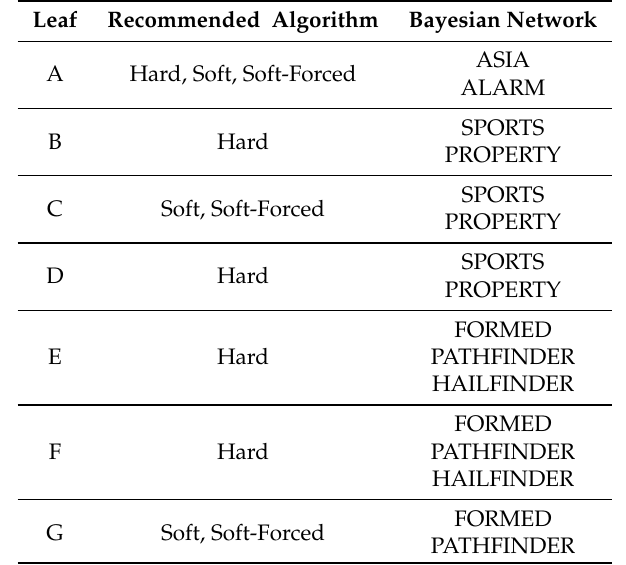
Figure 1. Decision tree for best practice guidance. Table 2. Recommended algorithm by decision tree